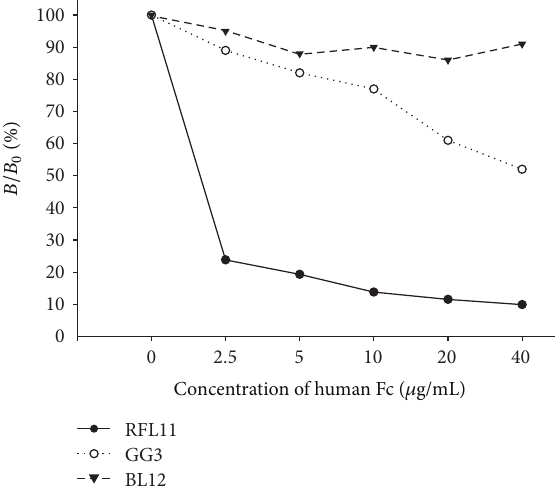
Figure 4: Competitive inhibition assay of RFL11 Fab antibody against the Fc fragment. The amount of bound Fab in the presence of free Fc inhibitor was measured and expressed as a percentage of the binding of Fab in the absence of an inhibitor. B and B0 denoted the amount of bound Fab in the presence and absence of the inhibitor,